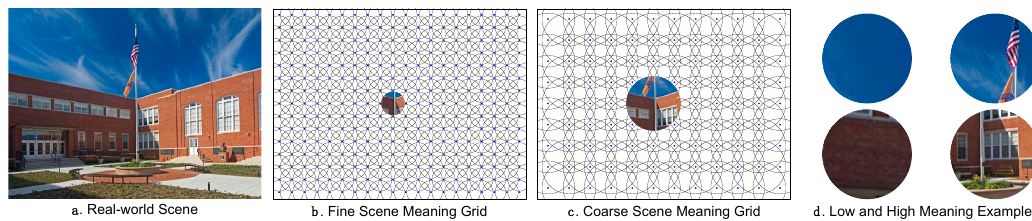
Figure 2. ( a ) A real-world scene; ( b ) fine scale, and ( c ) coarse scale patches from the patch grids; ( d ) examples of patches rated low (left column) and high (right column) in meaning.